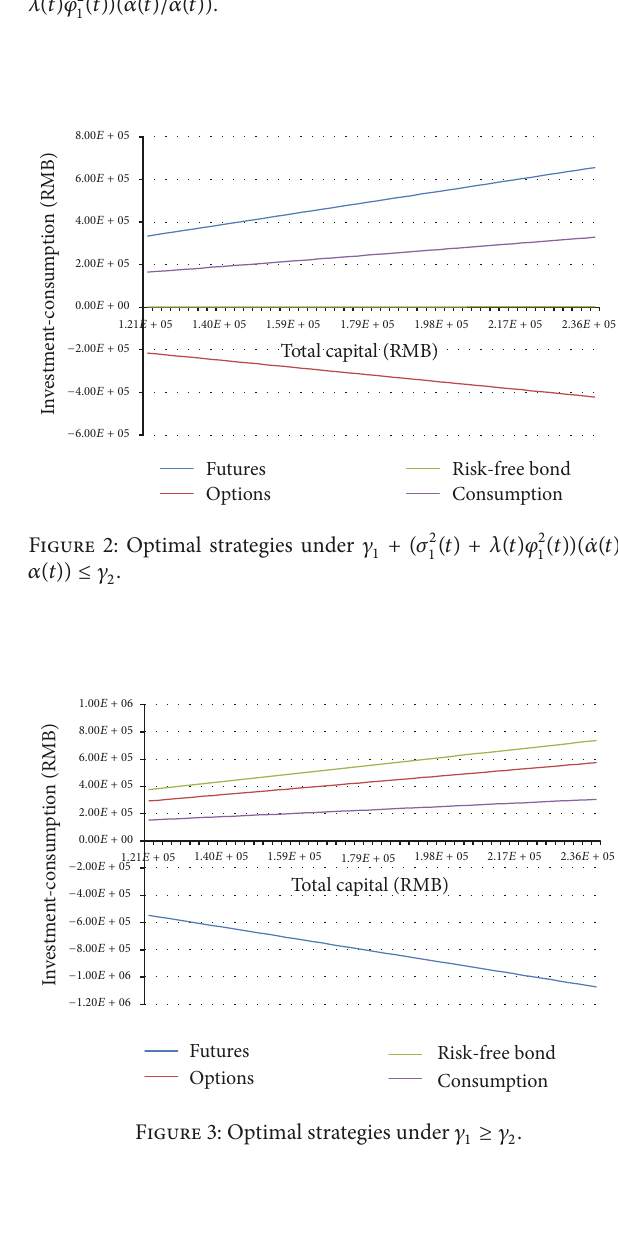
Figure 1: Optimal strategies under 𝛾 1 < 𝛾 2 ≤ 𝛾 1 + (𝜎 2 1 (𝑡) + 𝜆(𝑡)𝜑 2